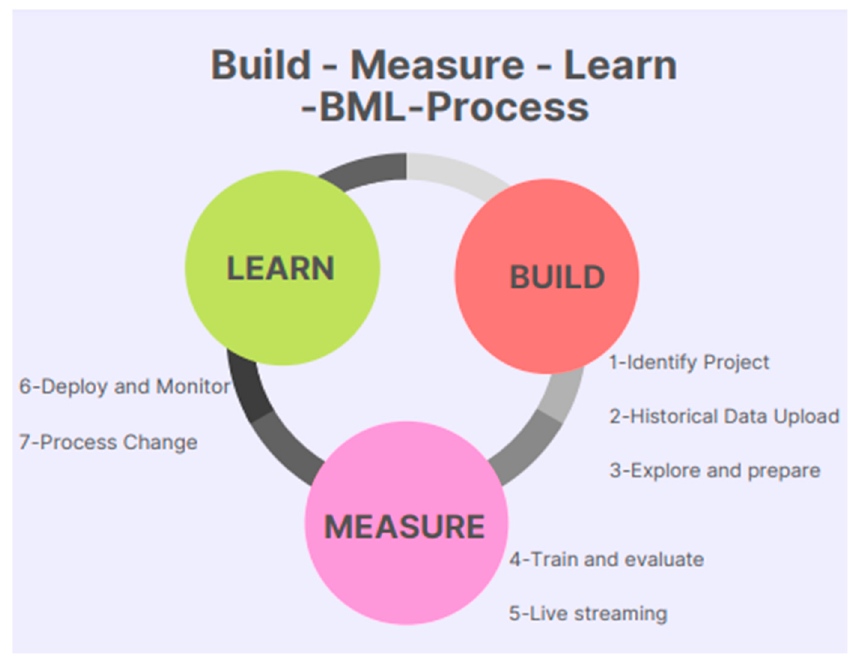
Figure 3. Lean startup process structured as Built–Measure–Learn (BML), and the seven. steps followed in the case. Source: Authors.